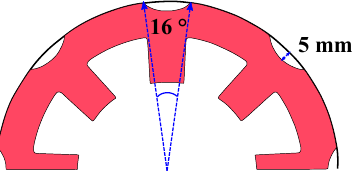
Figure 17. Notches added to the stator back iron of the 8/6